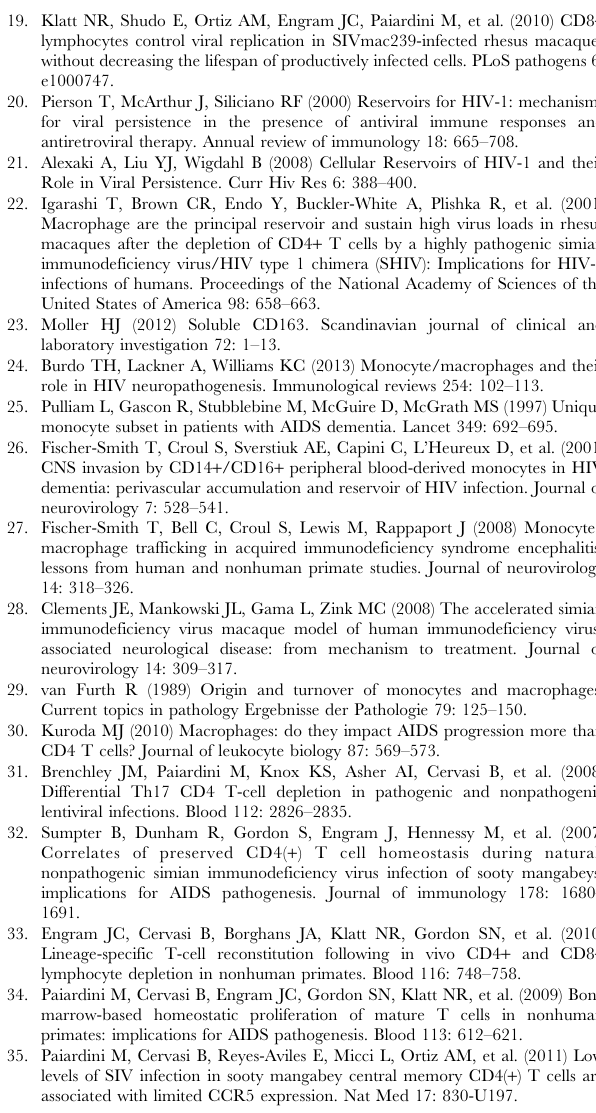
RMs (n= 12) included in the study. Statistical analyses were determined by Spearman rank correlation tests. Figure S3 The number of TUNEL – but not active caspase 3 – positive cells in the brain is significantly higher in CD4-depleted SIV-infected RMs than in controls. The number of cells staining positively for TUNEL ( a ) and active Caspase 3 ( b ) within brain tissue is shown for SIV- infected controls (closed circle; n= 3), CD4-depleted animals (orange square; n= 4), and CD4-depleted, ART-treated RMs (open square; n= 7). Table S1 Survival of CD4 depleted SIV-infected RMs. Antibody-mediated depletion of CD4 T cells prior to SIV infection results in fast disease progression, with seven out of eight RMs that required to be euthanized few days after initiation of ART. The table lists the day post-infection and post-ART initiation, as well as the CD4 count, at which each animal was sacrificed. *RVl11 survived throughout the